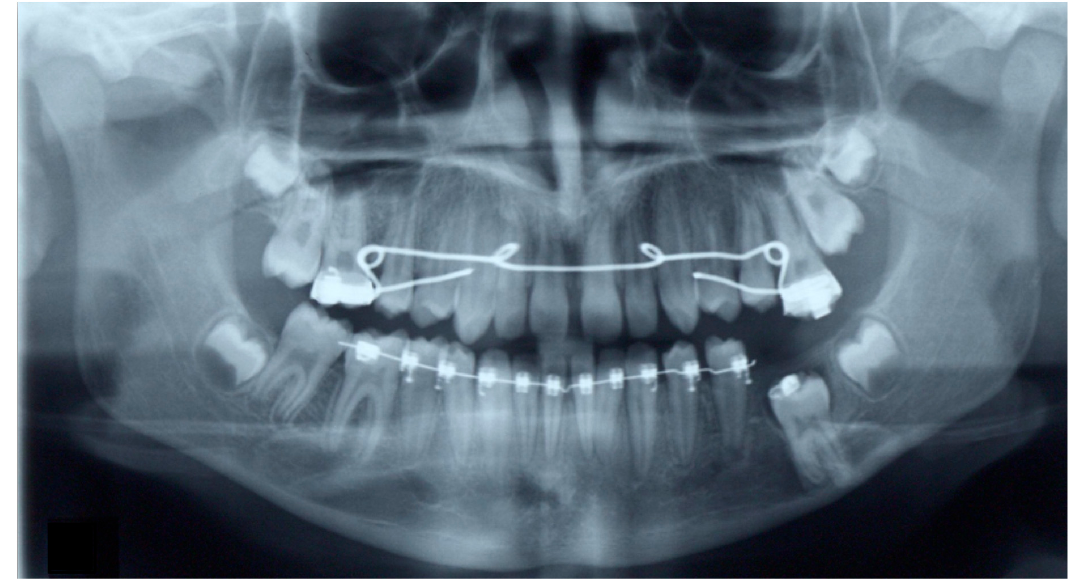
Figure 4. Panoramic radiograph two months after the surgical exposure of the first permanent mandibular molar. Note the reduction in size of the former cystic cavity and the more favorable axis of the impacted tooth.